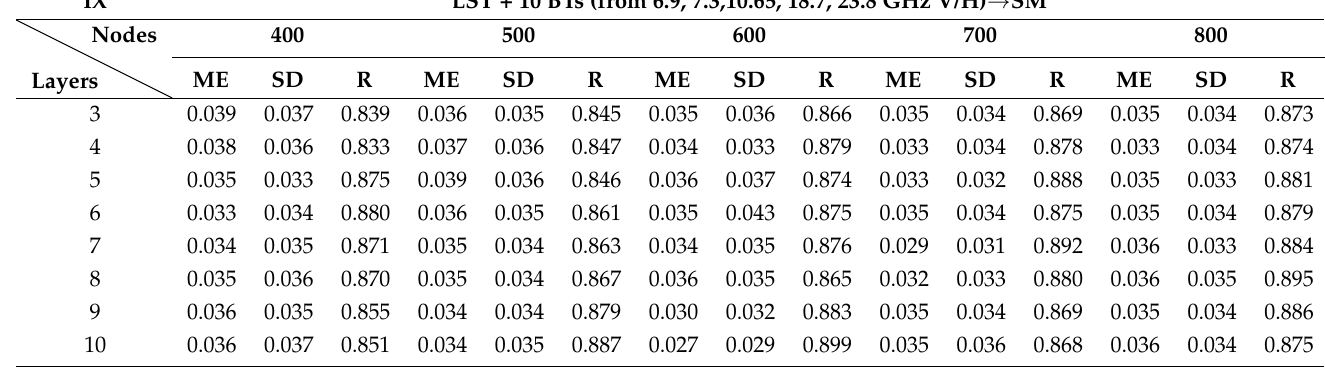
Table 9. LST and ten channels are used to retrieve SM (LST and brightness temperature combination of ten